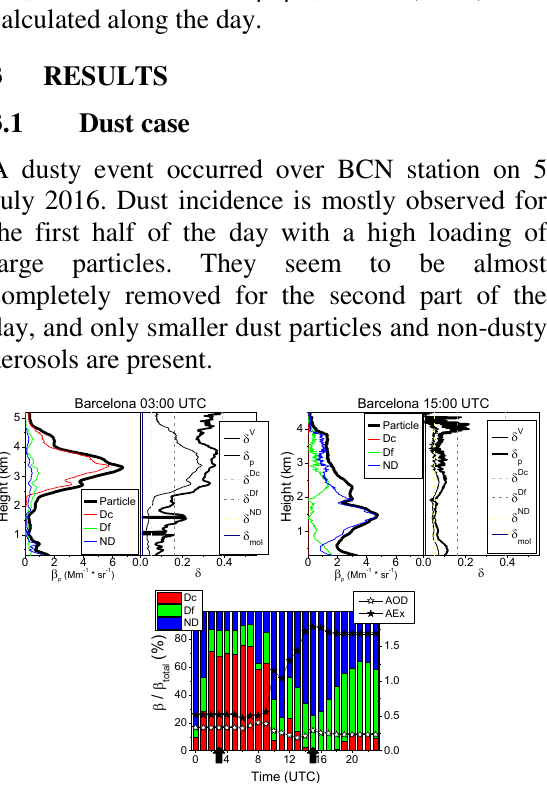
Figure 1. Dust case. (Up) Both vertical backscattering ) (total particle and for each specific coefficient (  p component, left panels), and linear depolarization ratio , right panels) at 03:00 (volume,  V , and particle,  p UTC (left) and 15:00 UTC (right). (Down) Evolution of the relative contribution of each aerosol component, (%), along the day. (Note: Dc - dust coarse; Df  /  total – dust fine, and ND – non-dusty aerosols). The time of those profiles shown in the upper panels are marked by black arrows. Daily AERONET/AOD and AEx values are also included (white and black stars, respectively).